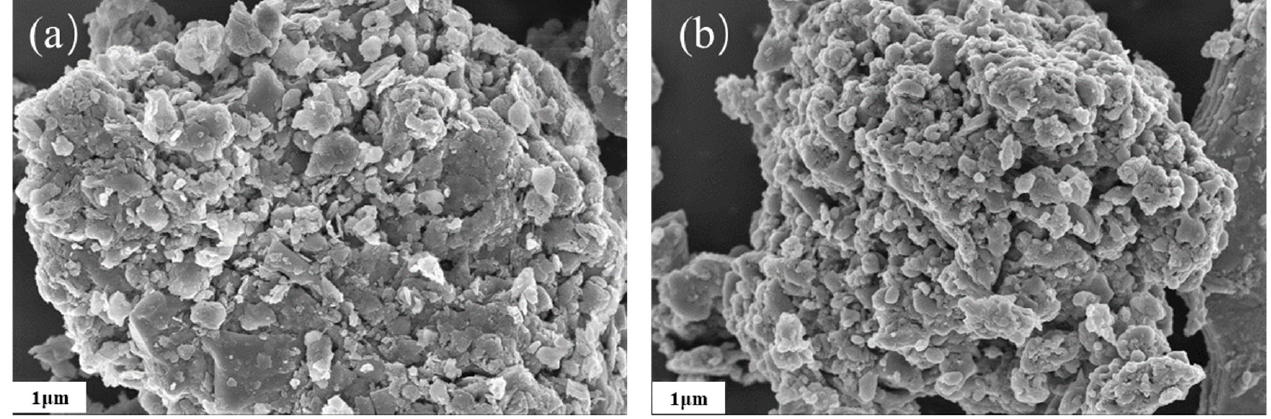
Figure 5. SEM of biochar ( a ) PS0 and ( b ) PS80. Table 3. Chemical Composition and Firing Behavior of red mud ‐ steel slag ‐ sludge.